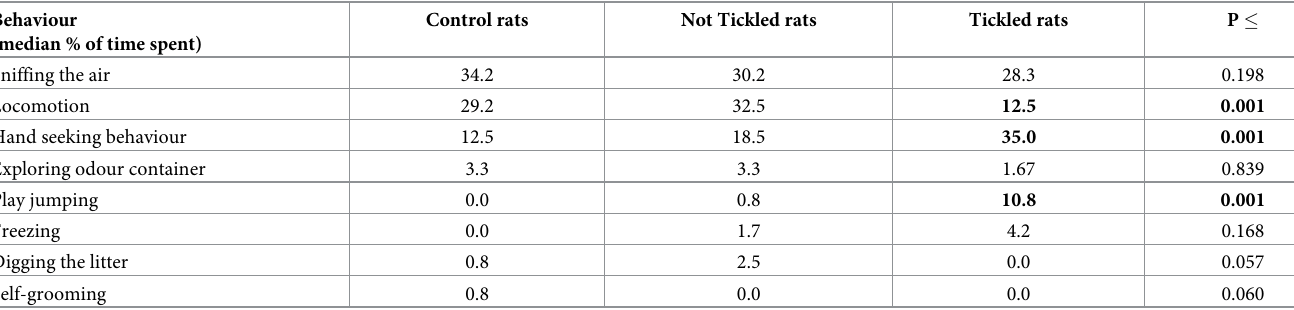
Median percentage of time spent in different behaviours by rats during pauses between tickling periods in the 5 th conditioning session. Control rats were never tickled, and data for Not Tickled rats are from the session with the non-conditioning odour, when the Tickled rats were subjected to the Not Tickled procedure. Within rows, a median in bold font differ significantly from the other medians.